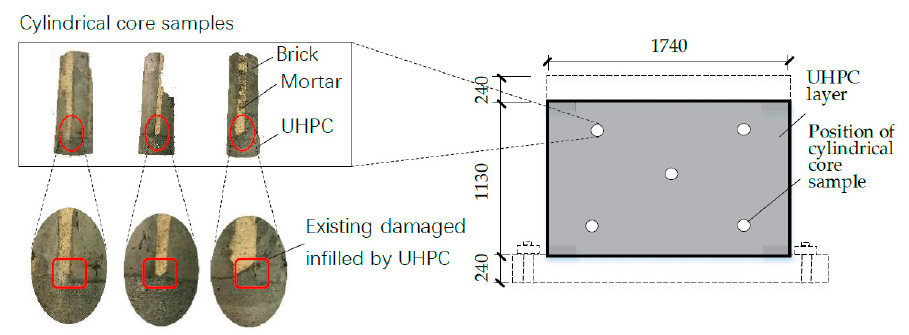
Figure 13. Interaction mechanism between the UHPC layer and the masonry substrate.